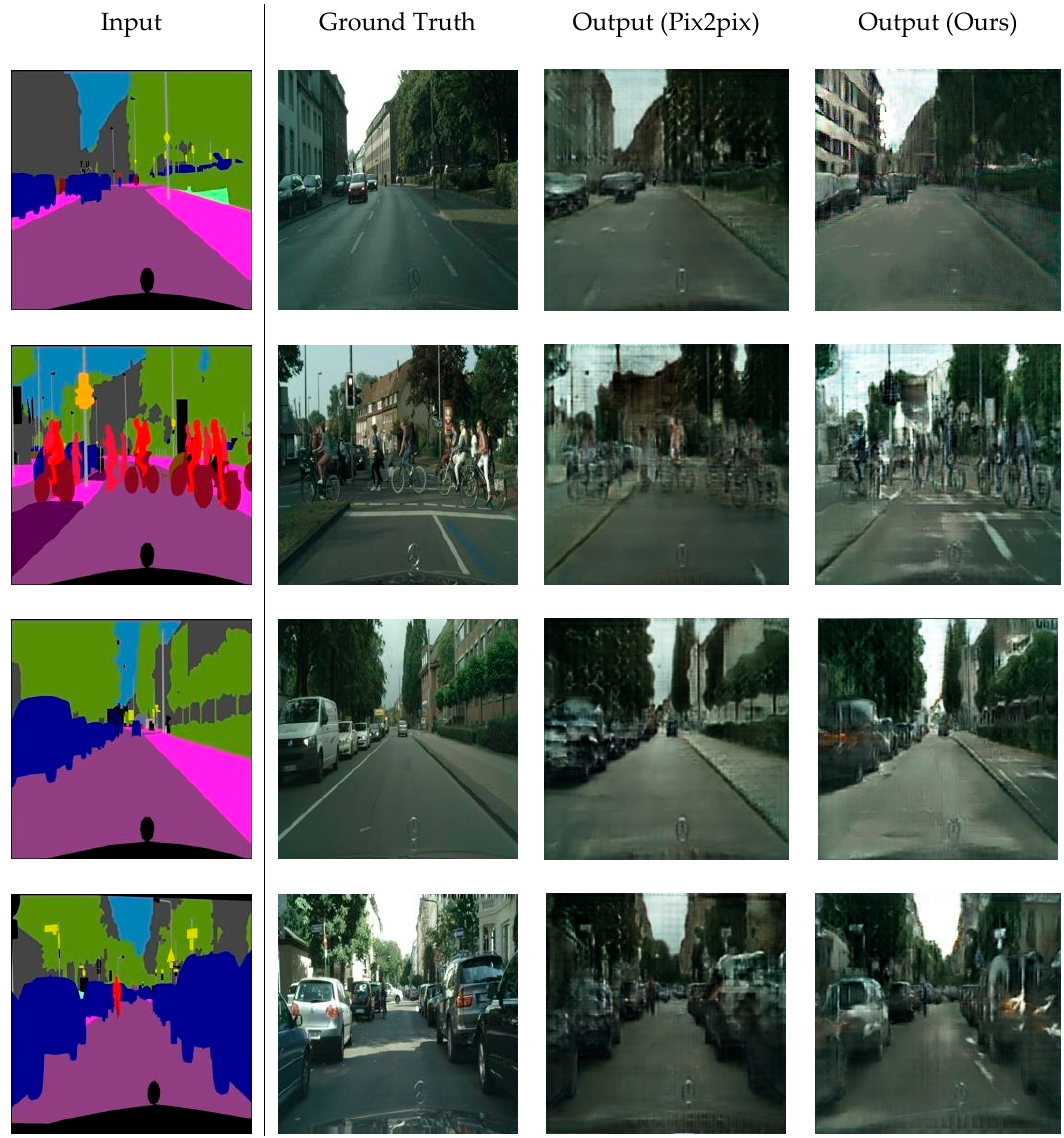
Figure A1. Comparison of Pix2pix and our model. The introduction of noise, including mixed textures, faded edges, and blurred objects, are mitigated in our model.